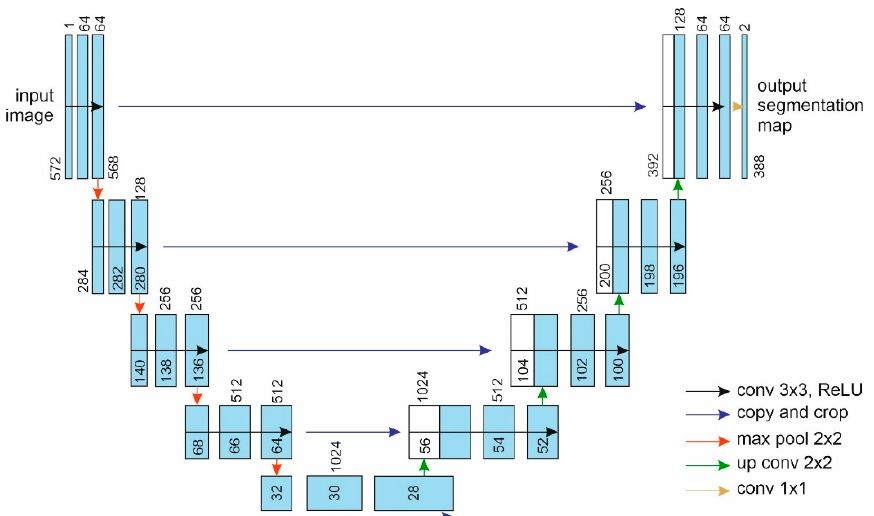
Figure 1. General architecture of the U-Net neural network. Blue rectangles indicate multichannel feature maps. The number of channels is given above. Copied feature maps are marked with white rectangles. The feature map size is indicated near the lower left edge. Arrows indicate the operation direction.